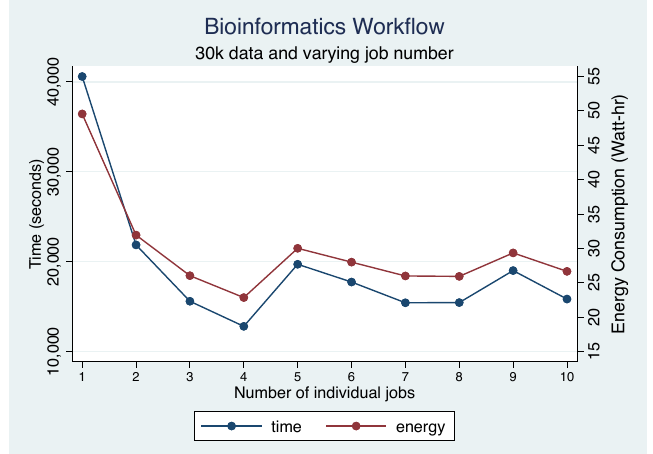
Figure 15. Varying number of jobs on 1 node cluster for 30 k